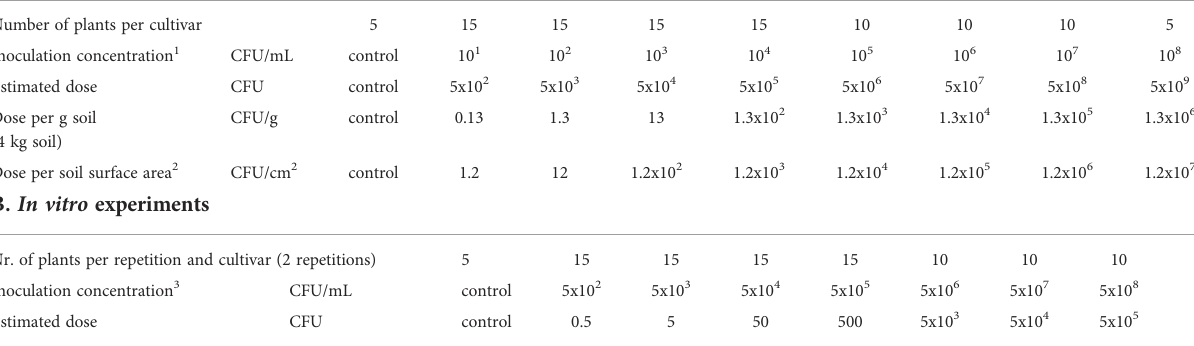
TABLE 1 Setup for dose-response experiments in greenhouse (A) and in vitro (B) for potato cultivars Kondor and HB, where potato plants were inoculated with selected concentrations of Ralstonia solanacearum